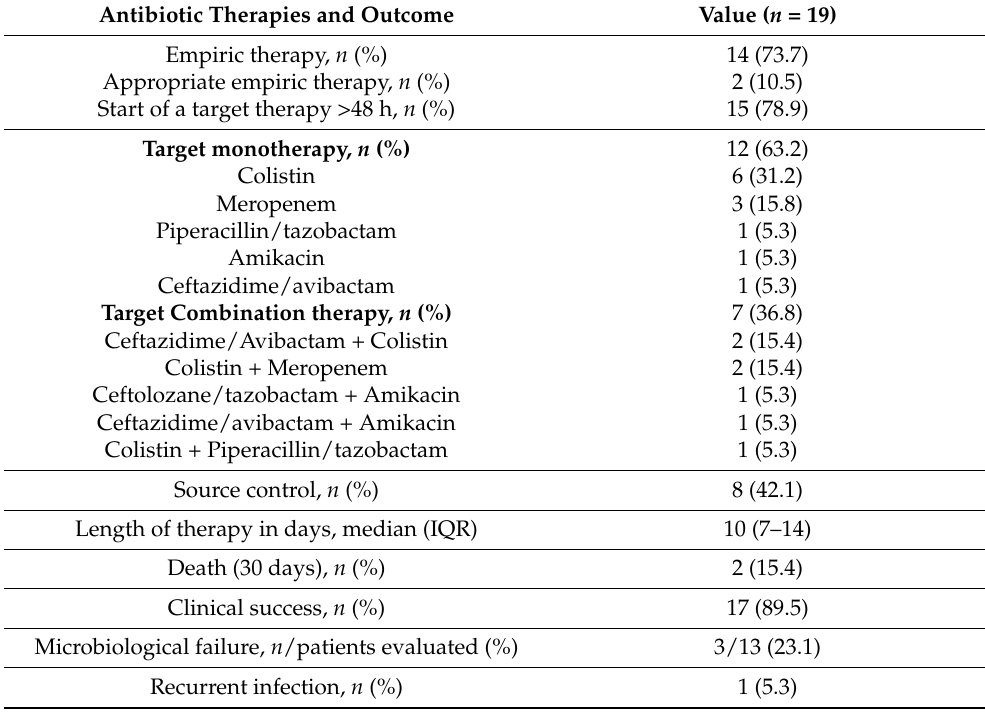
Table 3. Antibiotic therapies and